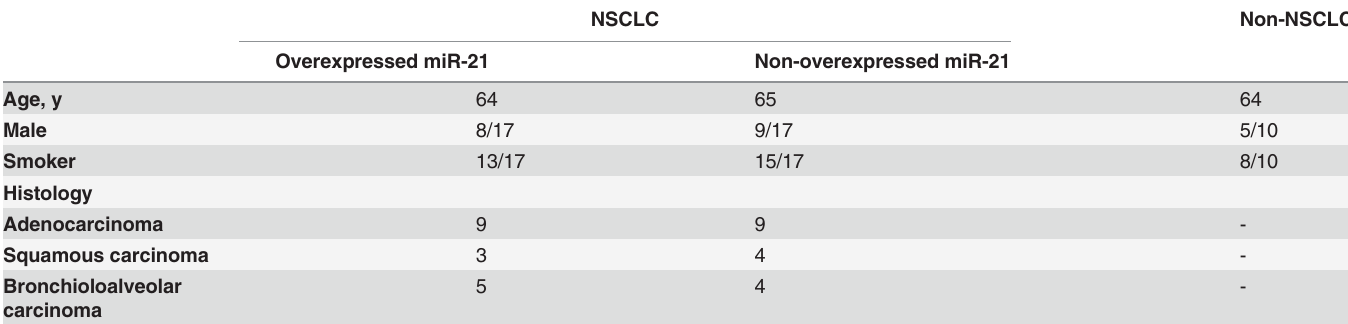
Table 1. Demographic and clinical characteristics.